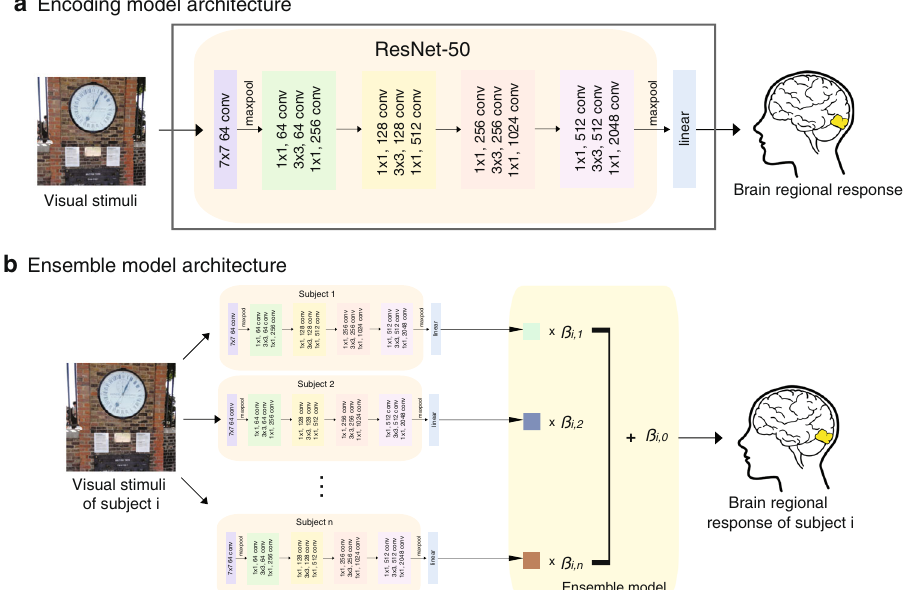
Fig. 1 Encoding model and ensemble model architecture. a The encoding model architecture. A feature extractor adopted from ResNet-50 8 extracts features from the input image and a linear readout maps the extracted features to the responses for a speci fi c brain region. b The ensemble model architecture. A group of n pretrained encoding models (where n = 7 or 8) are used to obtain a set of predicted activations, which are combined via a linear model fi tted via ordinary least squares to optimally predict the query subject ’ s regional brain the predicted activations (i.e., the correlation between the predic- tions of each pair of subjects) and the ISC of measured activations.